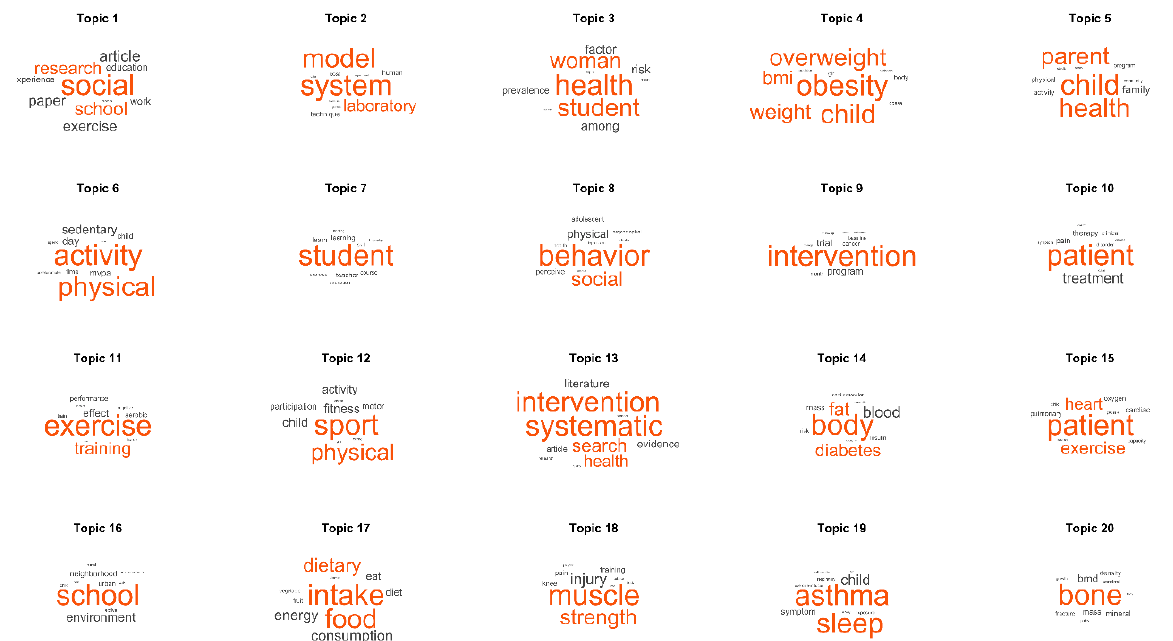
Figure 5. Words most representative of the topics found in the model LDA. Topics are ordered by probability of appearing in the total corpus of documents, topic 1 being the most likely and topic 20 the least likely. The larger word size represents a higher probability of appearing in the documents associated with each topic (for words with a lower probability, see Table